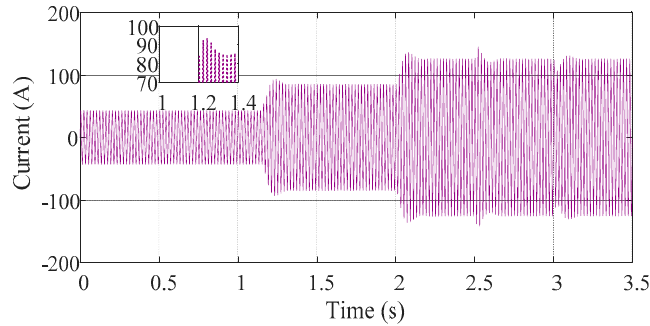
Figure 19. Output current (Phase A) of conventional VSG.